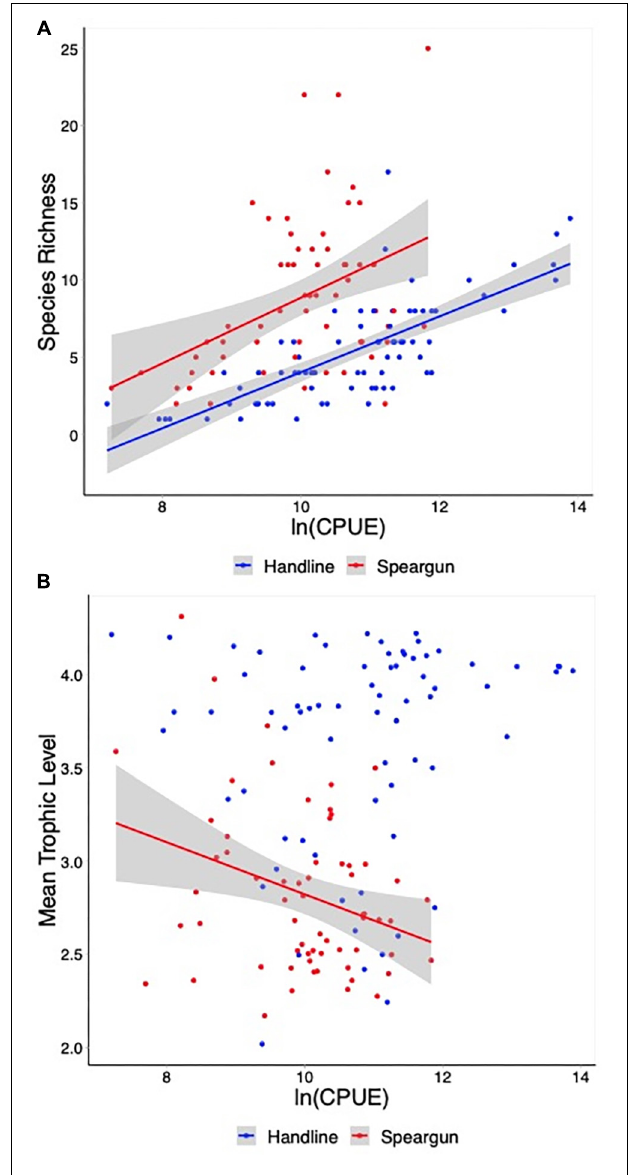
FIGURE 3 | The relationship between catch per unit effort (CPUE) and (A) species richness, (B) mean trophic level, for both handline and speargun. CPUE were log-transformed for normality. Significant ( p < 0.05) linear relationships are represented with shaded 95% confidence